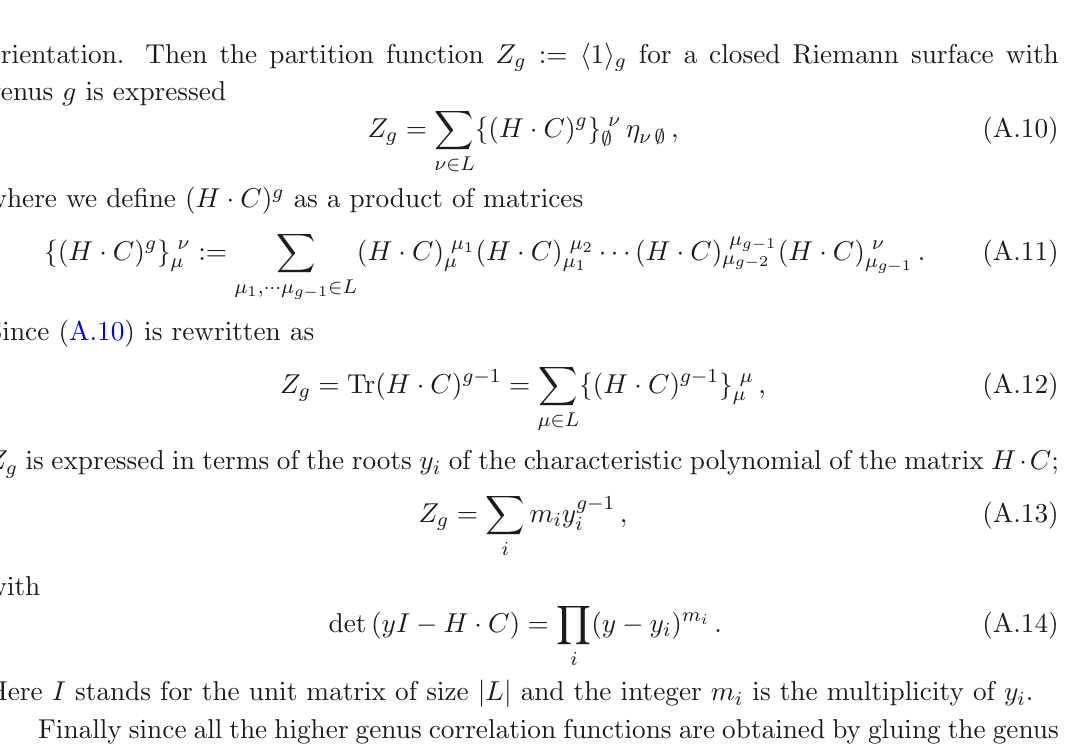
Figure 4 . Handle creating